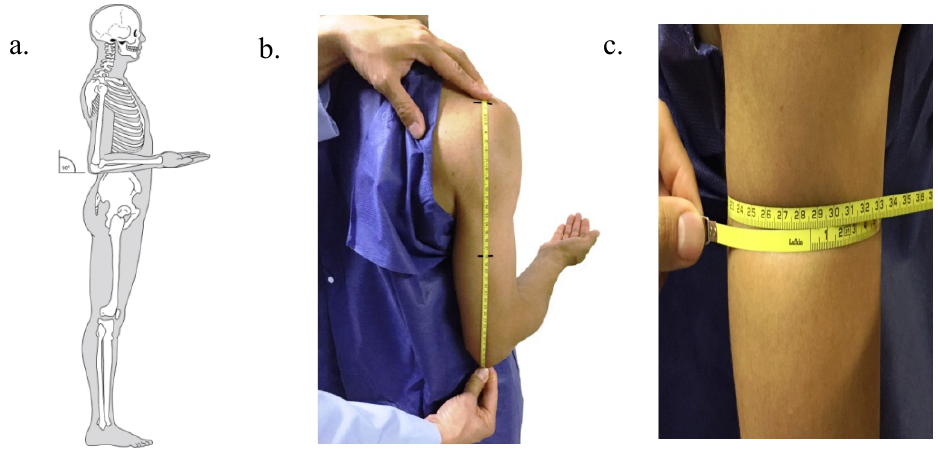
Figure 1 . MUAC measurement in a standing position